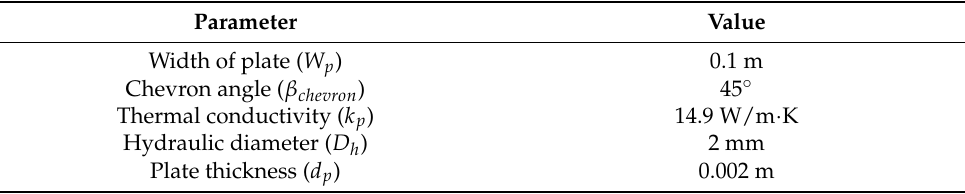
Table 4. The constant geometric parameters of the plate heat